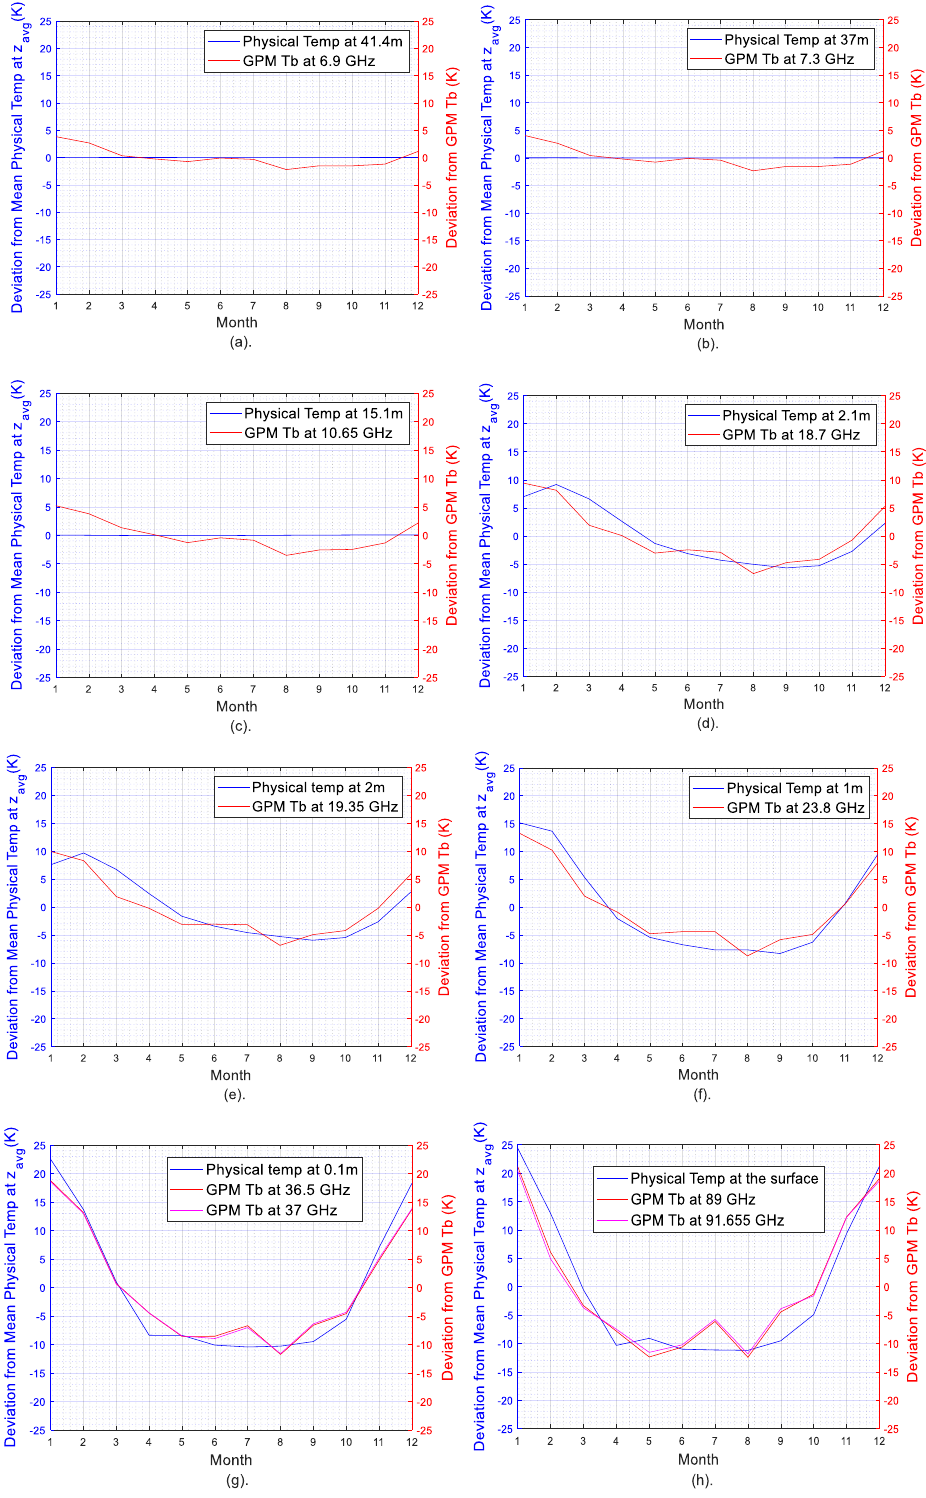
Figure 17. Correlation between GPM-measured brightness temperatures at ( a ) 6.9 GHz, ( b ) 7.3 GHz, ( c ) 10.65 GHz, ( d ) 18.7 GHz, ( e ) 19.35 GHz, ( f ) 23.8 GHz, ( g ) 36.5 – 37 GHz, and ( h ) 89 – 91.65 GHz and physical firn temperatures at the associated average depths of sensitivity ( a ) 41.4 m, ( b ) 37 m, ( c ) 15.1 m, ( d ) 2.1 m, € 2 m, ( f ) 1 m, ( g ) 0.2 m, and ( h ) surface. The high correlation between brightness and physical temperatures imply that multifrequency GPM observations can be utilized to profile internal firn temperatures versus depth.